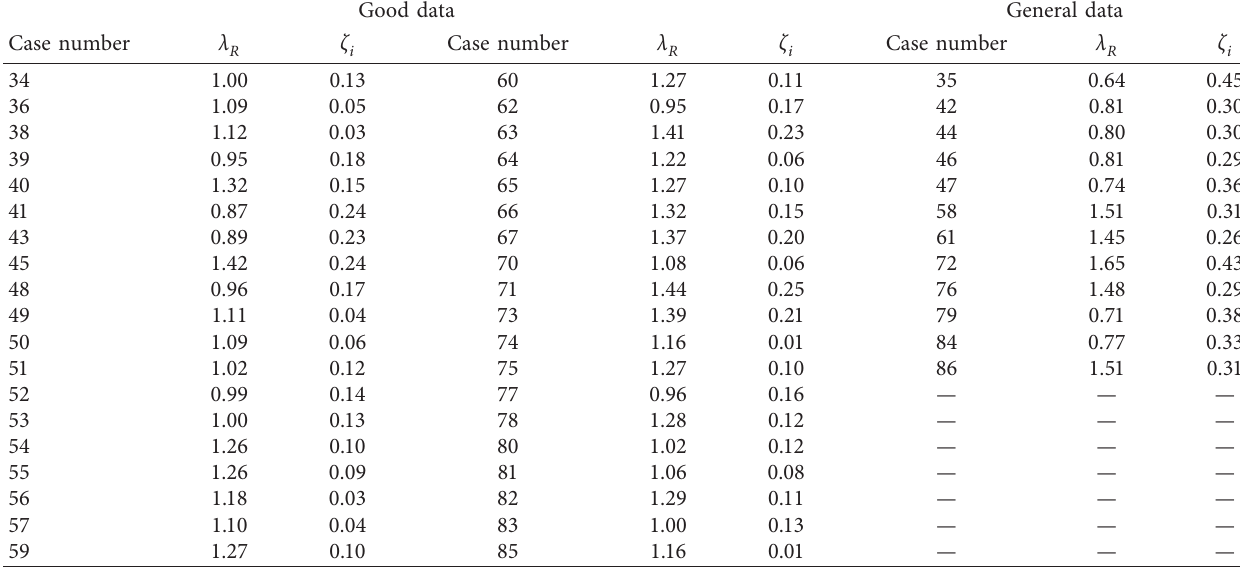
Table 4: Classified results of load test data in cohesive soil.